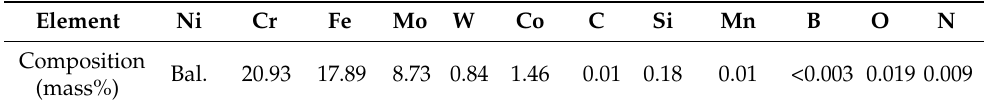
Table 1. Chemical composition of Hastelloy-X